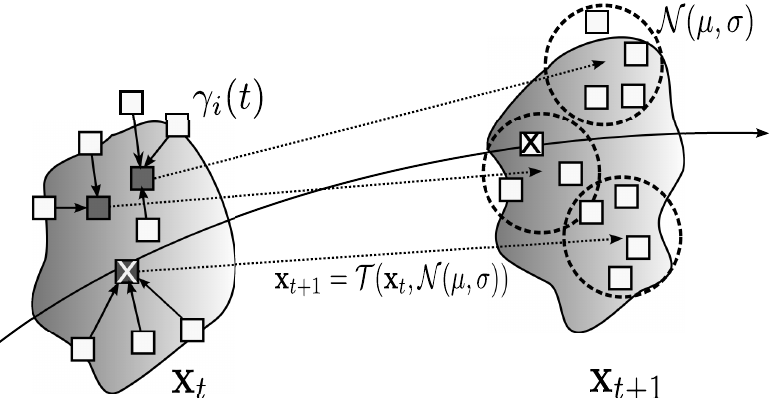
Figure 2: The SMC method for tracking objects, illustrating resampling and update